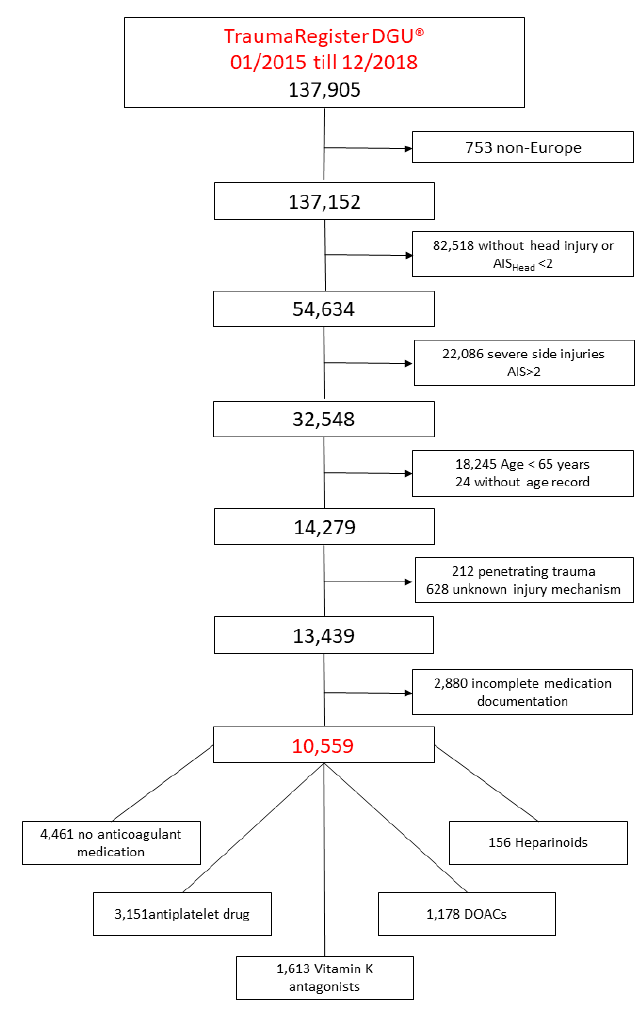
Figure 1. Study outline. Table 2. Base data of the patient collective. NM: no anticoagulant medication; APD: antiplatelet drugs; VKA: vitamin K antagonist; DOAC: direct oral anticoagulants; ISS: Injury severity score; ASA: American Society of Anaesthesiologists score.